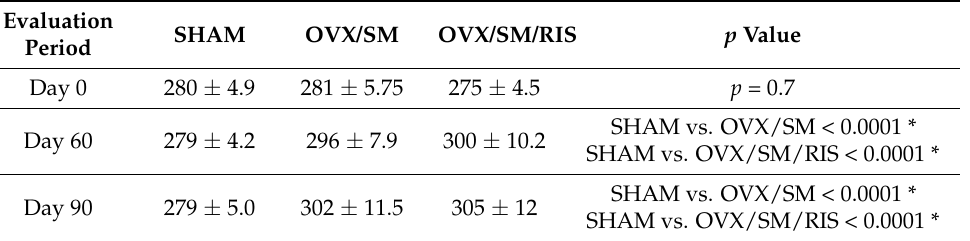
Table 3. Lee index values (mean ± standard deviation) of SHAM, OVX/SM, and OVX/SM/RIS on days 0, 60, and 90.